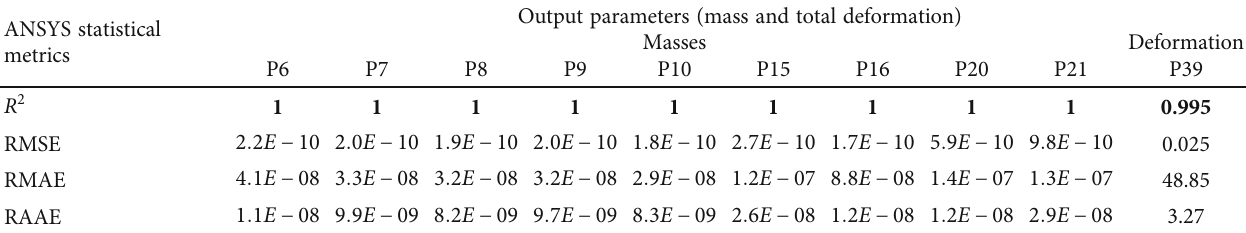
Table 6: Accuracy of the goodness of fi t in the response surface (RS).